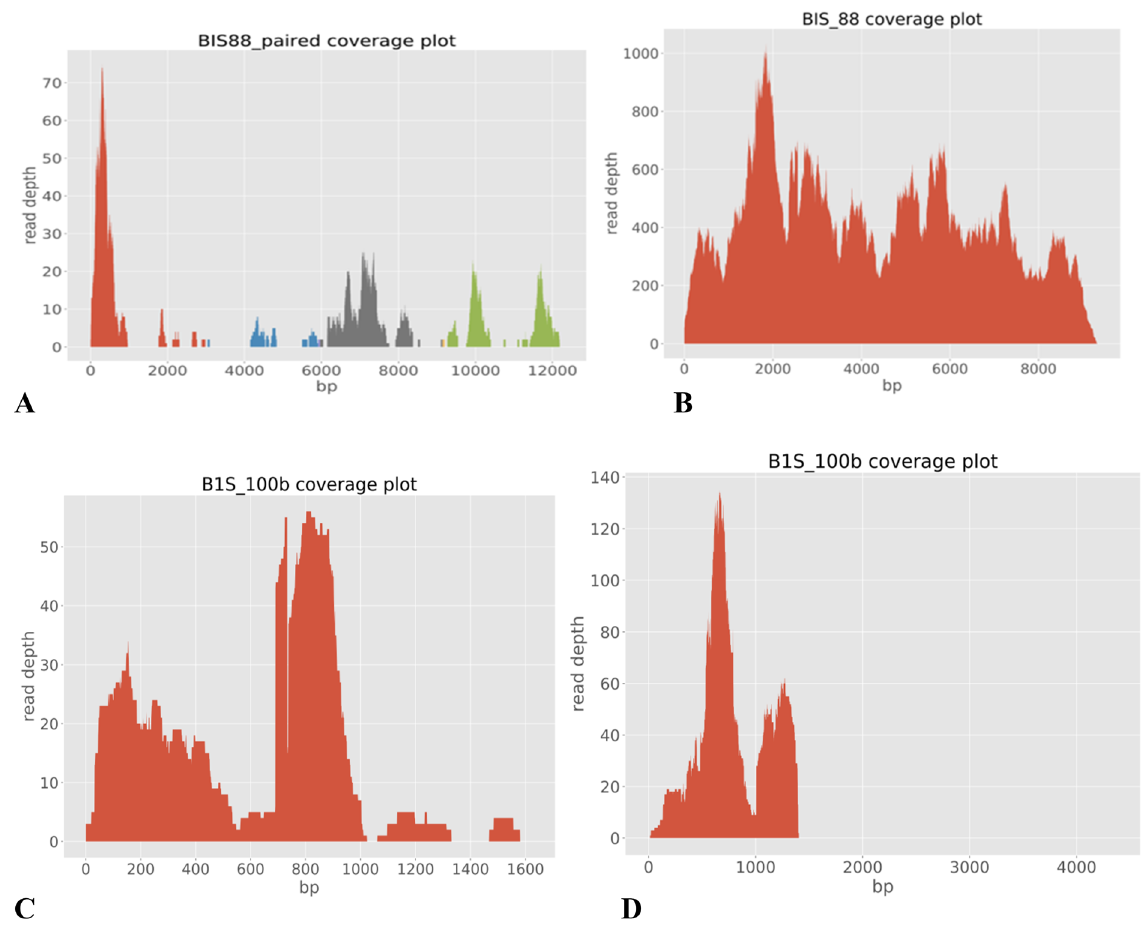
Figure 6. Coverage plot for ( A ) Fako virus segments, ( B ) Tesano Aedes virus, ( C ) Chaq like virus, ( D ) Verdadero virus. ( A ) Red = Segment 1, Blue = Segment 2, Grey = Segment 3 and Green = Segment